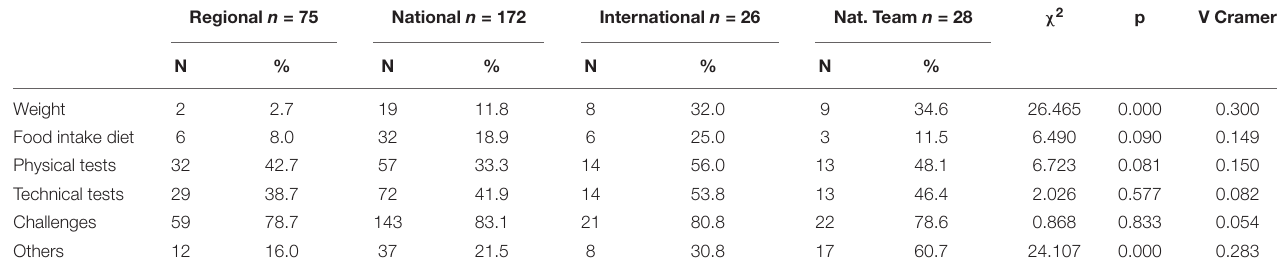
TABLE 5 | Evaluation and monitoring means.